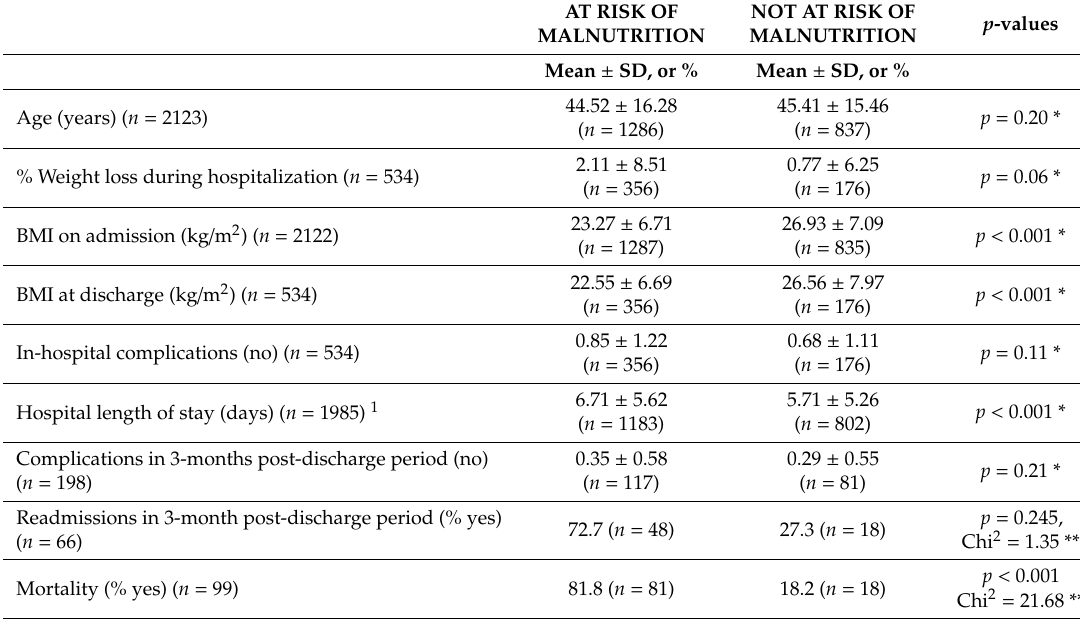
Table 4. Associations between at-risk for malnutrition on admission to hospital and variables. AT RISK OF